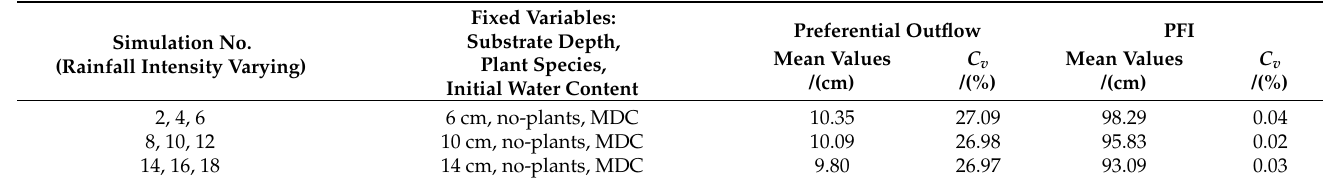
Table 13. Mean values and C v of VAS preferential outflow and PFI for different rainfall intensities. Fixed Variables: Substrate Depth, Simulation No. (Rainfall Intensity Varying)